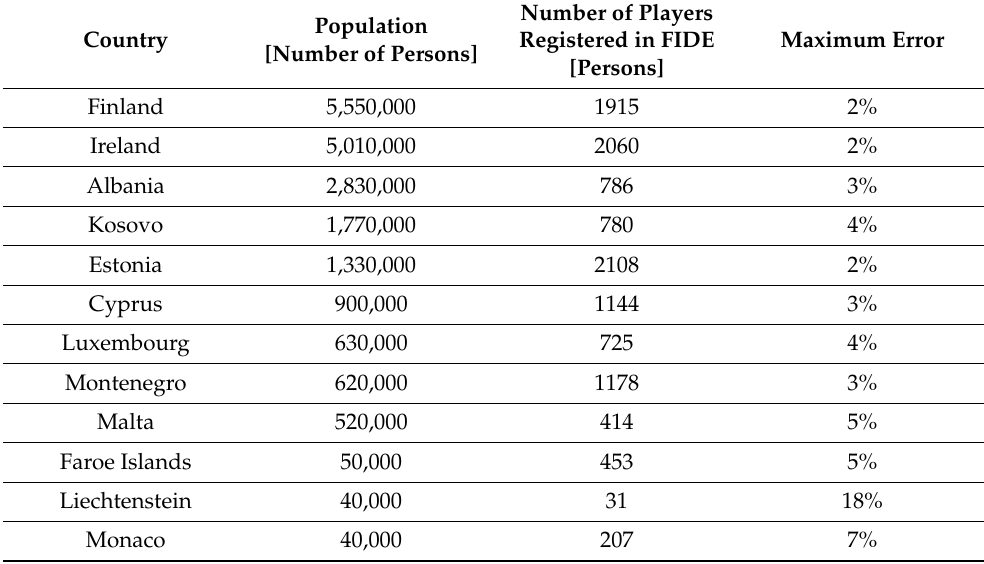
Table 2. Maximum error percentage for the number of players registered with FIDE in each Euro- pean